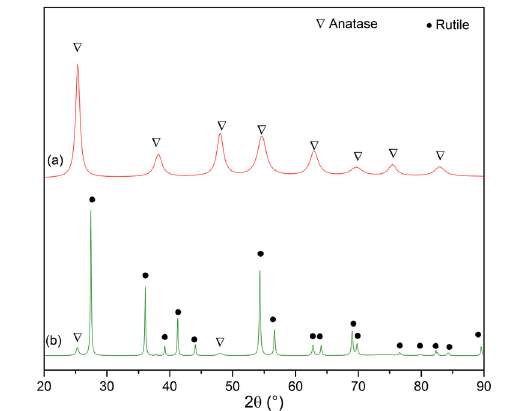
coated MWCNT, synthetized Figure 2. XRD patterns of TiO 2 by the sol-gel process and calcined at (a) 500ºC and (b) 1000ºC. Figure 3. FEG-SEM images of (a) Pristine MWCNT and (b) Functionalized MWCNT. and 1000ºC. The formation of the TiO phase is confirmed, 2 having two different structures depending on the calcination temperature. At 500ºC the diffraction peaks correspond to Samples of TiO -coated MWCNT, obtained after the 2 the Anatase structure (JCPDS Nº 21-1272), as observed in sol-gel process using different titanium isopropoxide Figure 2A. The sample calcined at 1000ºC exhibited peaks predominantly from the Rutile phase ( JCPDS Nº 21-1276), see Figure 2B, along with a small amount of Anatase indicated by the presence of its main diffraction peak (101) at 2θ = 25.28º. From the equation (1), the weight percent of the Anatase phase, W , was estimated to be 4.9%. A (1) . In equation (1), I denotes the intensity of strongest A Anatase reflection, (101; 2θ=25.28º.) and I is the intensity R of strongest rutile reflection (110; 2θ=27.44º) 39,40 .